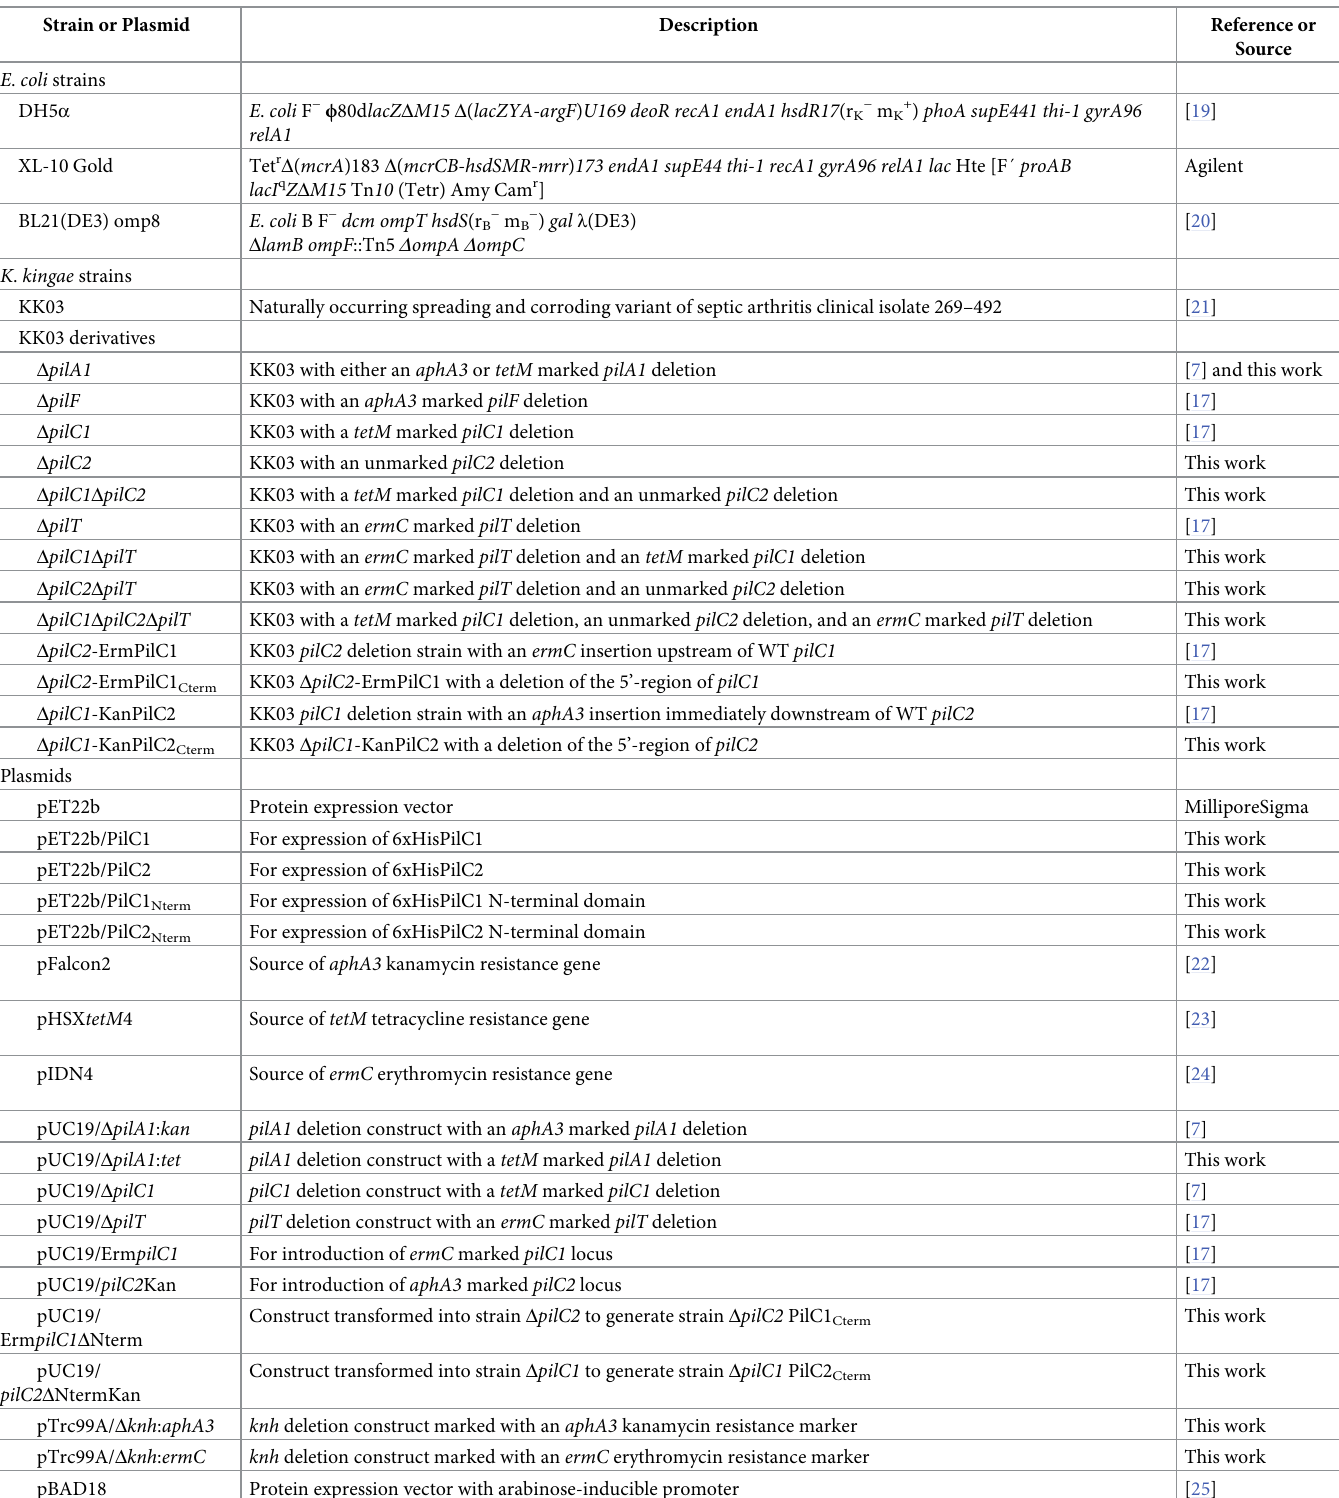
Table 1. Strains and plasmids used in this study. Strain or